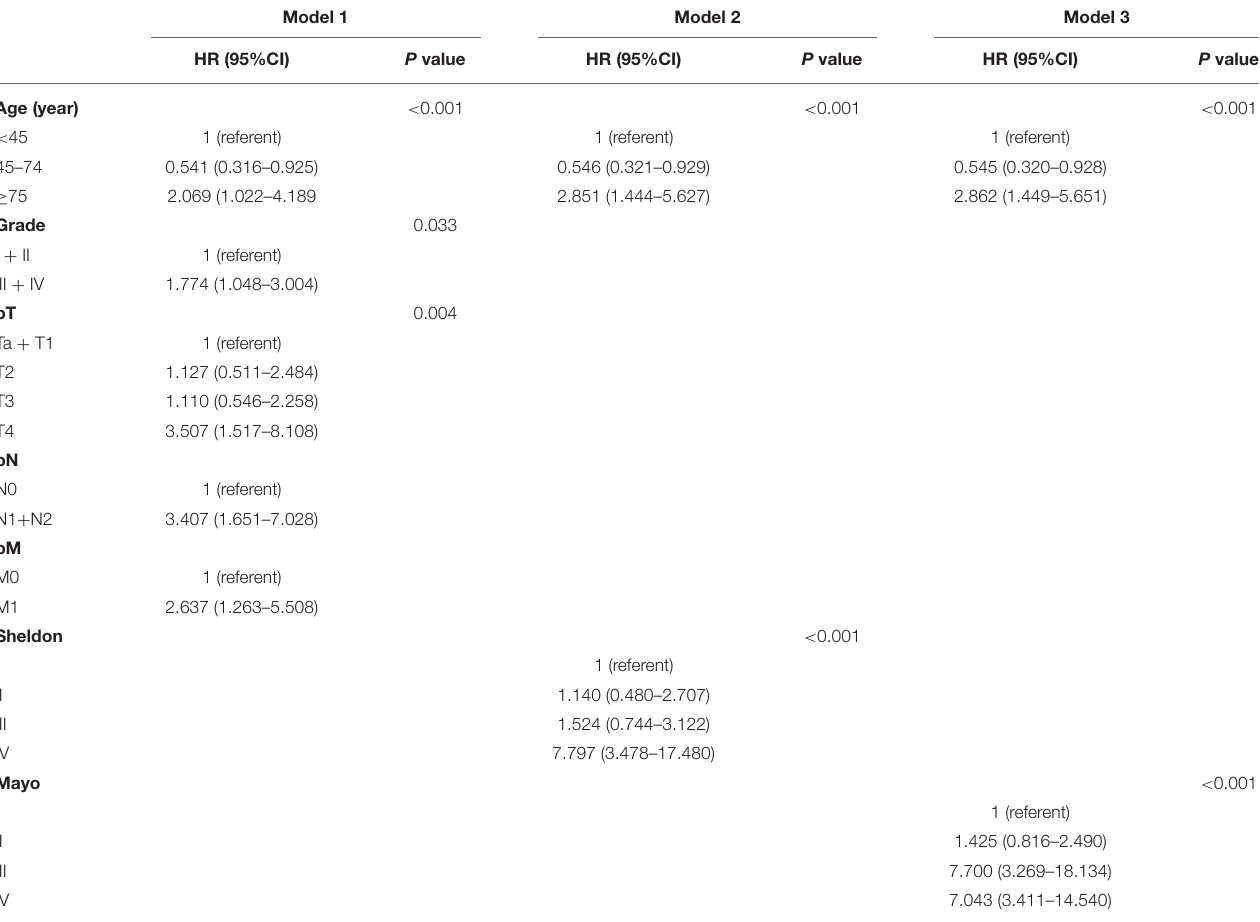
TABLE 1 | Multivariate Cox analyses for the prediction of overall survival with urachal